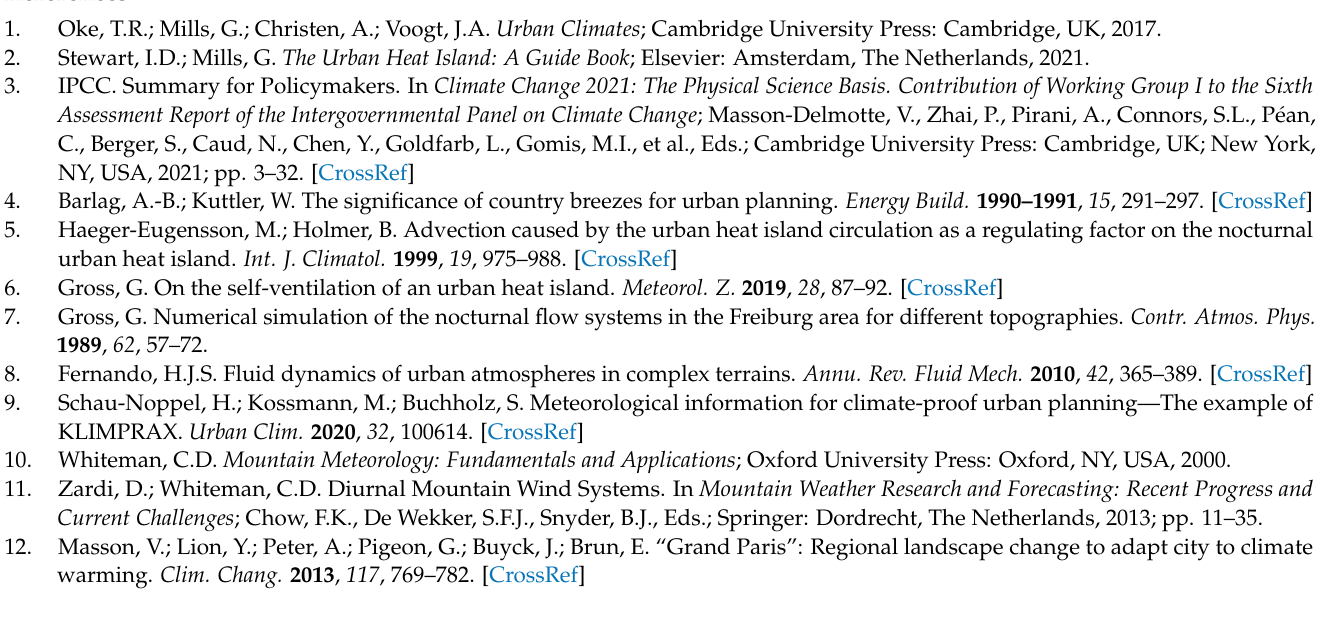
Figure A3. Land cover classification map in the 12 km × 12 km subdomain (Figure 2a) with the city border of Aschaffenburg (red), quantitatively delimitated thermal hot spots (white) and cold air formation areas (blue). Black contour lines represent terrain elevation in 25 m height intervals.